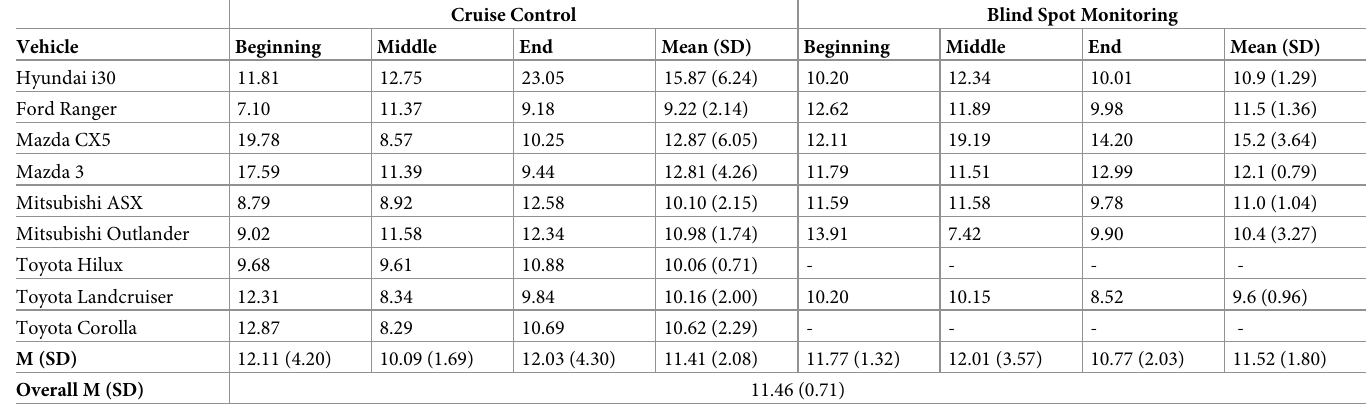
Table 6. Readability analysis of vehicle